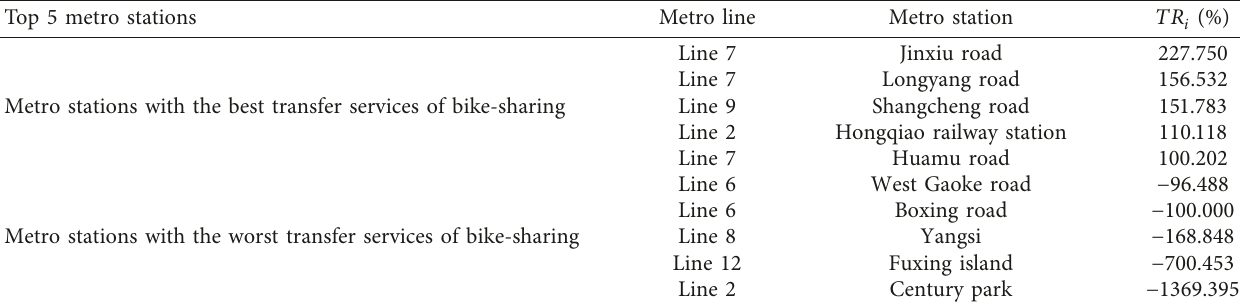
Figure 10: Evaluation of bike-sharing transfer services for different metro stations. Table 3: Top 5 Metro stations with the best (or worst) transfer services of